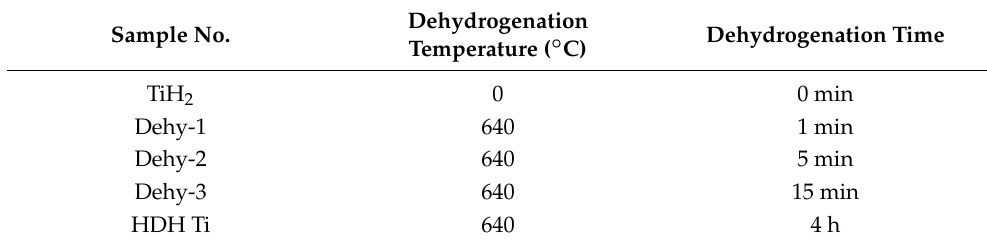
Table 1. Parameters of heat treatments of individual samples. Sample